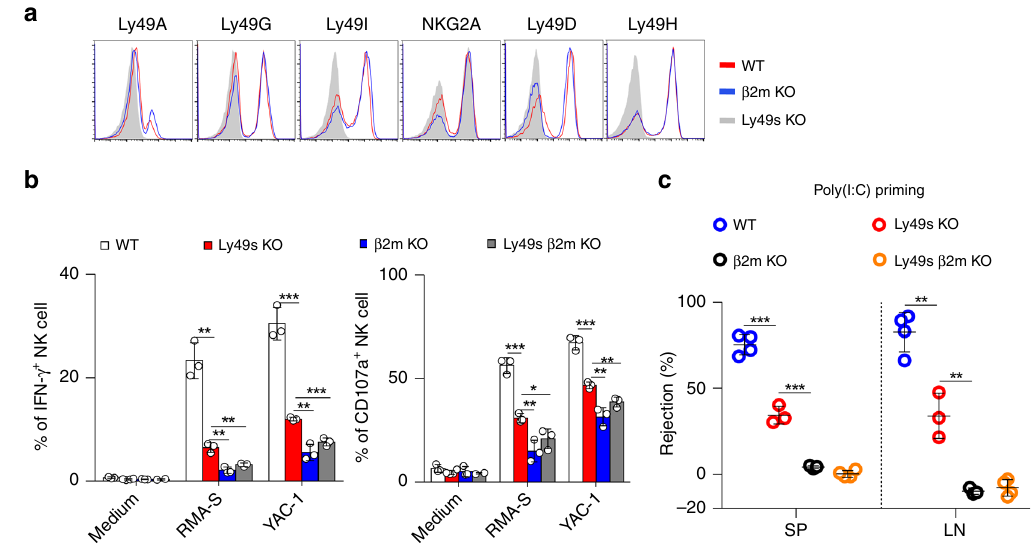
Fig. 5 Ly49-family deletion does not rescue β 2M-null NK-cell function. a Flow cytometry analysis of the expression of Ly49-family receptors and NKG2A on splenic CD3 − NKp46 + NK cells from WT (red line) and β 2m − / − (blue line) mice; Ly49s KO mice (grey fi lled curve) served as the negative control. b Poly(I:C)-primed splenocytes from the indicated mice were stimulated with tumour target cells. Percentages of IFN- γ + (left panel) and CD107a + (right panel) gated CD3 − NKp46 + NK cells were analysed. c In vivo rejection of β 2M-de fi cient splenocytes (similar to Fig. 3a). Each symbol represents an individual mouse. Data shown represent two ( c ) or at least three ( b ) independent experiments. Mean ± SD is shown. * p < 0.05, ** p < 0.01, *** p < 0.001